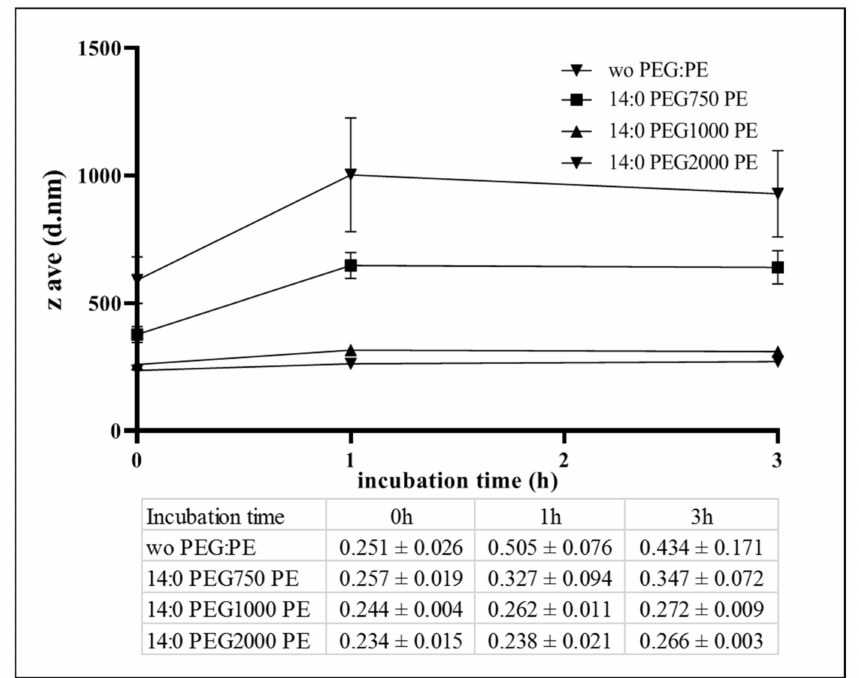
Figure 10. Dynamic size and PDI of cosol_MCLs in cell culture medium after incubation at 37 ◦ C. Cosol_MCLs with various PEG-PE (14:0 PEG750-PE, 14:0 PEG1000-PE, 14:0 PEG2000-PE) or